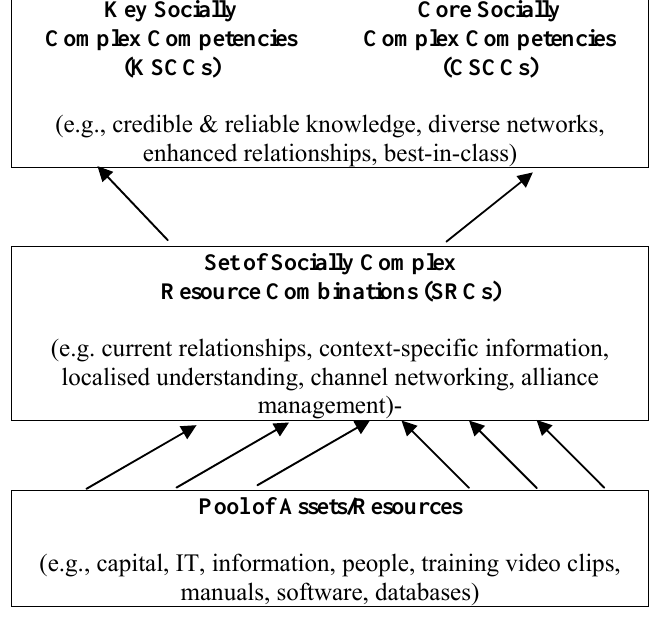
Figure 1: Assets combine to make SRCs, that serve as bases for competitive advantage when organisations compete on